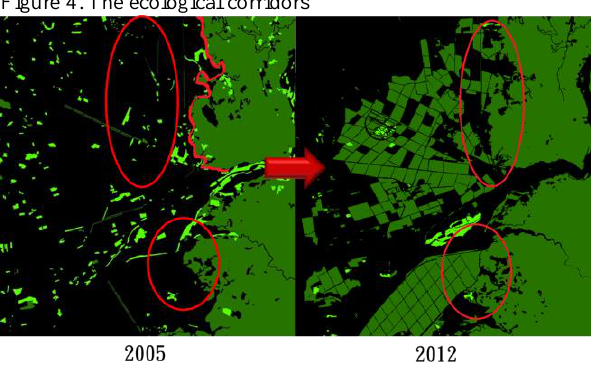
Figure 4. The ecological corridors